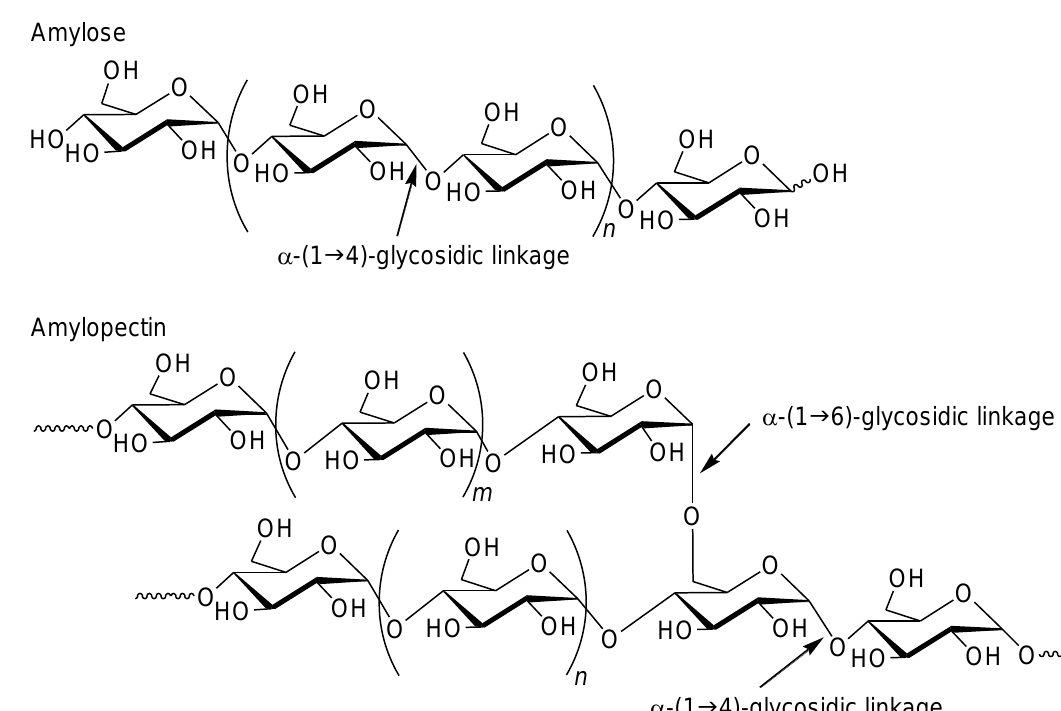
Figure 1. Structures of amylose and